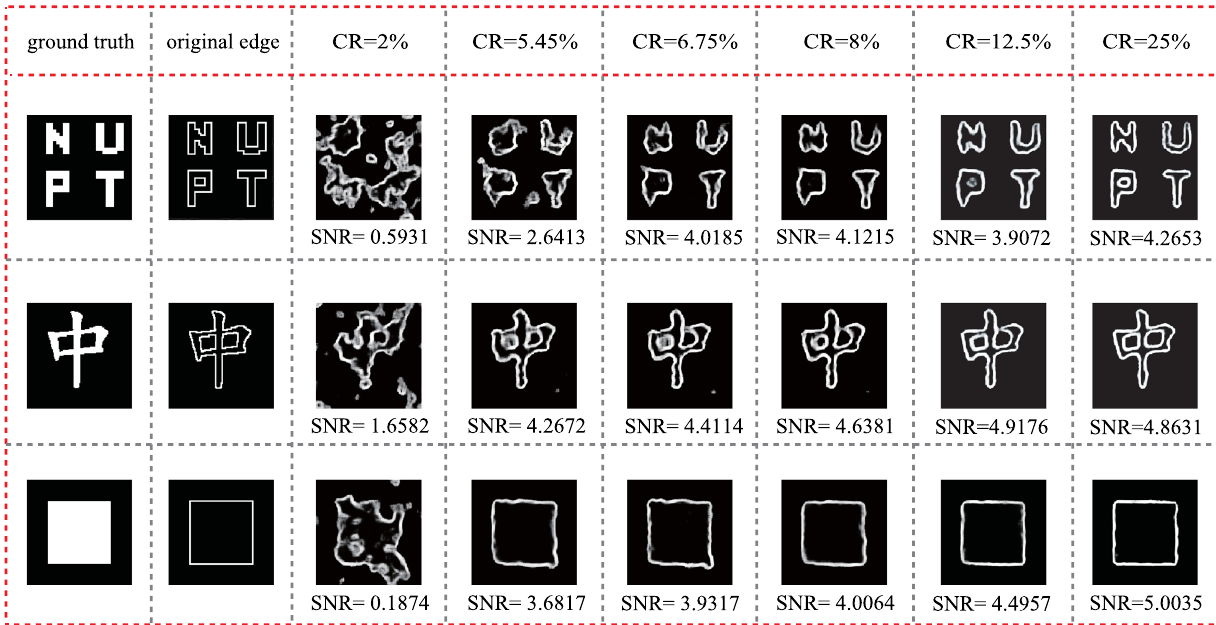
Experimental results with the proposed scheme, where “original edges” are achieved by applying Sobel operator on the “ground truth”